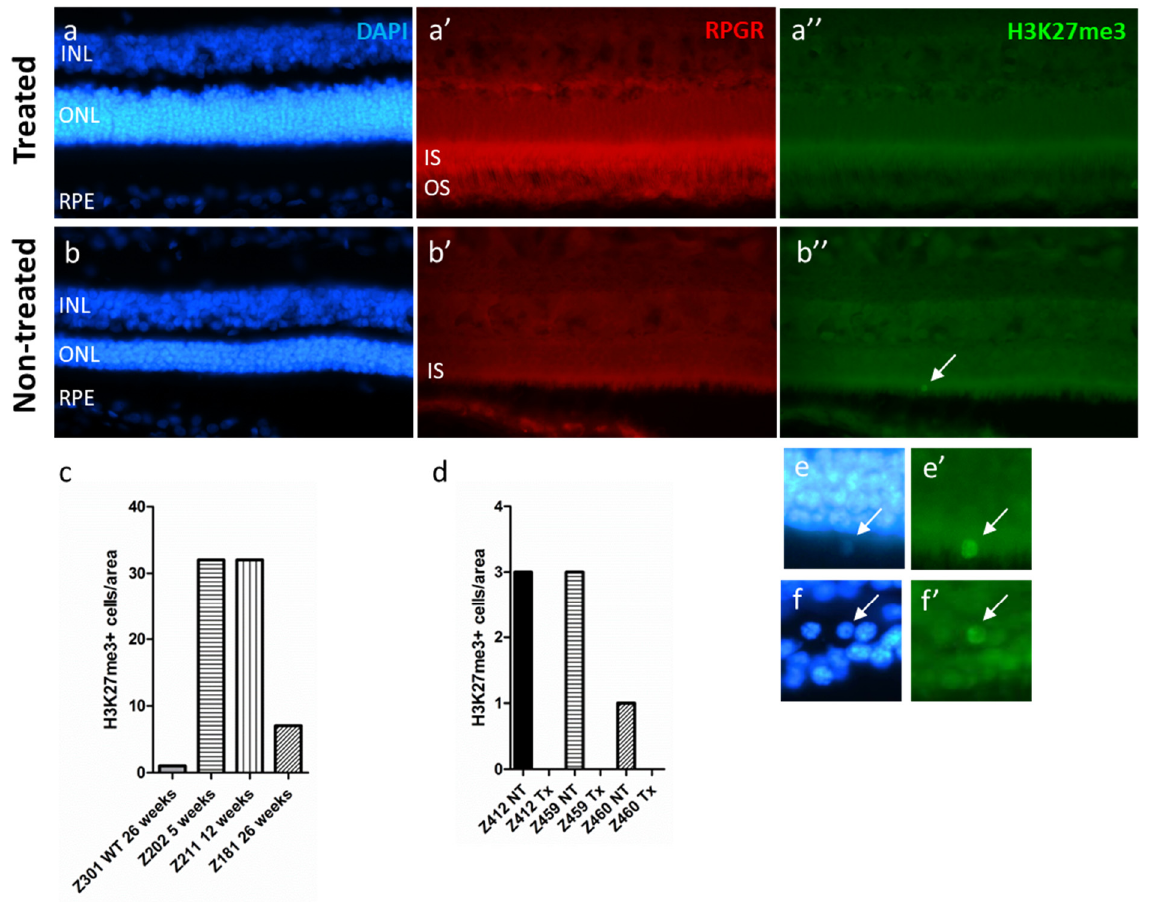
Figure 5. Absence of H3K27me3 h mark following gene therapy in RPGR-XLRP mutant dogs. In a previous study affected XLPRA2 dogs received a subretinal injection of an AAV2/5 vector coding for hRPGRstb , the expression of which can be detected by IHC, allowing the delineation of the treated area. ( a , a ′ , a ′′ ) Cryosections of a RPGR -XLRP mutant dogs’ treated retina labelled with DAPI, RPGR, and H3K27me3. Note the presence of the RPGR in the inner segments (IS) and the absence of H3K27me3 accumulation in the retina. ( b , b ′ , b ′′ ) Same labellings for a non-treated dog. Remark the absence of the RPGR labelling and the presence of an H3K27me3 h -positive cells in the ONL (arrow) which is mislocalized. ( c ) Quantification of the H3K27me3 h -positive cells in the ONL of WT and mutant dogs at different ages and ( d ) in AAV2/5- hRPGRstb vector treated (Tx) and non-treated (NT) RPGR -XLRP mutant dogs. For area definition, please see the material and method section. ( e , e ′ ) magnification of the H3K27me3 h -positive cell in ( b ′′ ). Another example of H3K27me3 h -positive cell which is present in the degenerating ONL is present in ( f , f ′ ).